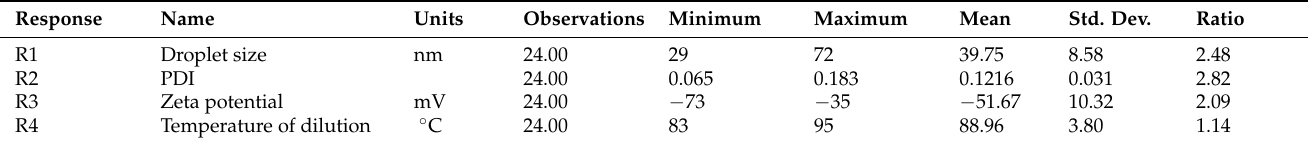
Table 7. Summary of the